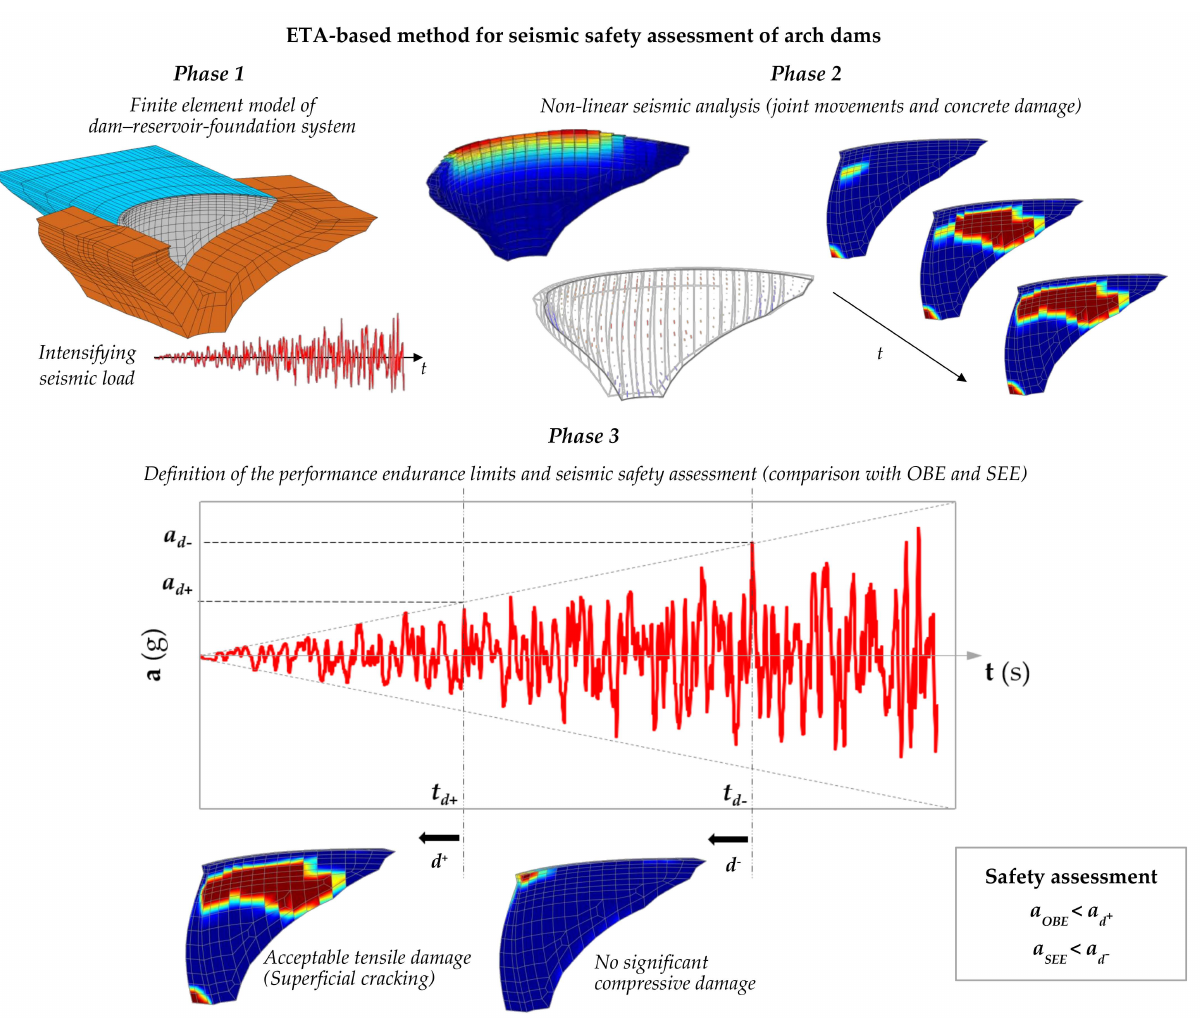
Figure 3. Schematic representation of the proposed methodology for seismic safety assessment of dams based on